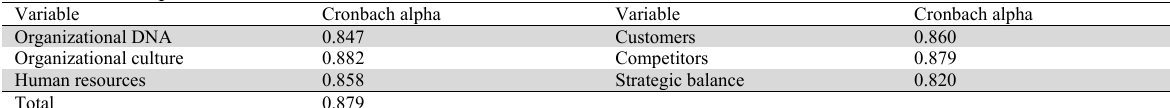
The Cronbach alpha coefficient values Variable